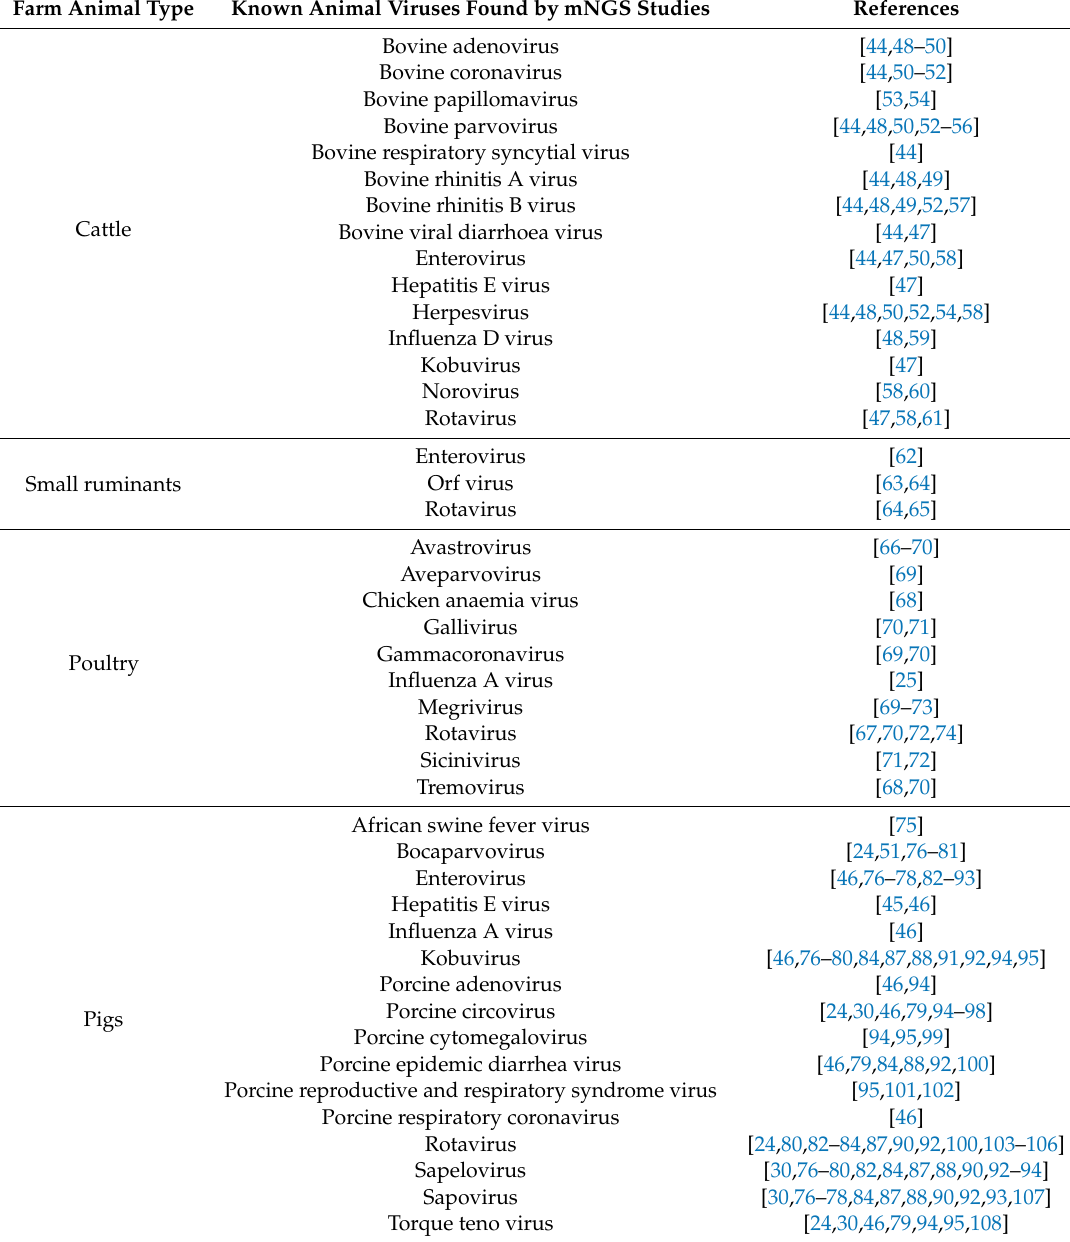
Table 1. Examples of known animal viruses reported in available metagenomic Next-Generation (mNGS)